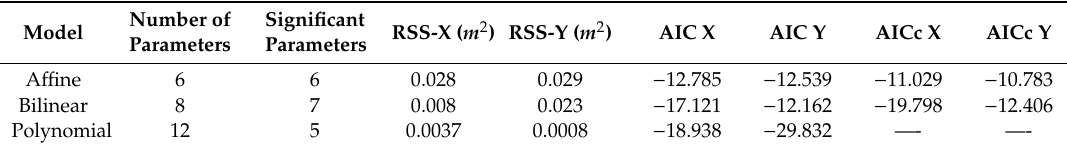
Table 2. Number of parameters, significant parameters, residuals sum of parameters (RSS) and values of AIC and AICc for each model.